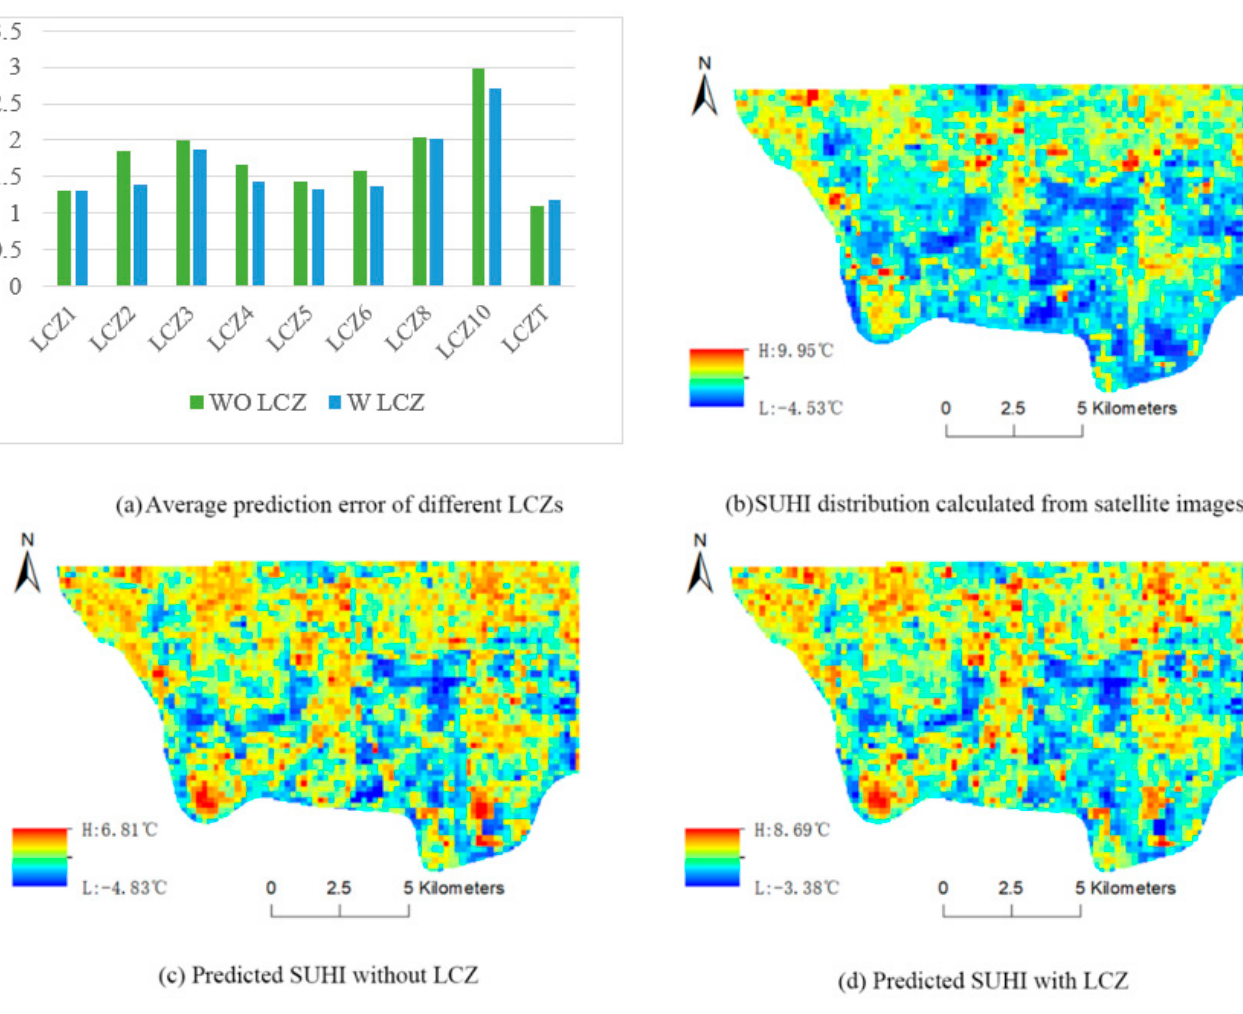
Figure 15. Comparison and distribution of nighttime model errors. Table 5. Comparison of SUHI D prediction error parameters with and without the LCZ model.